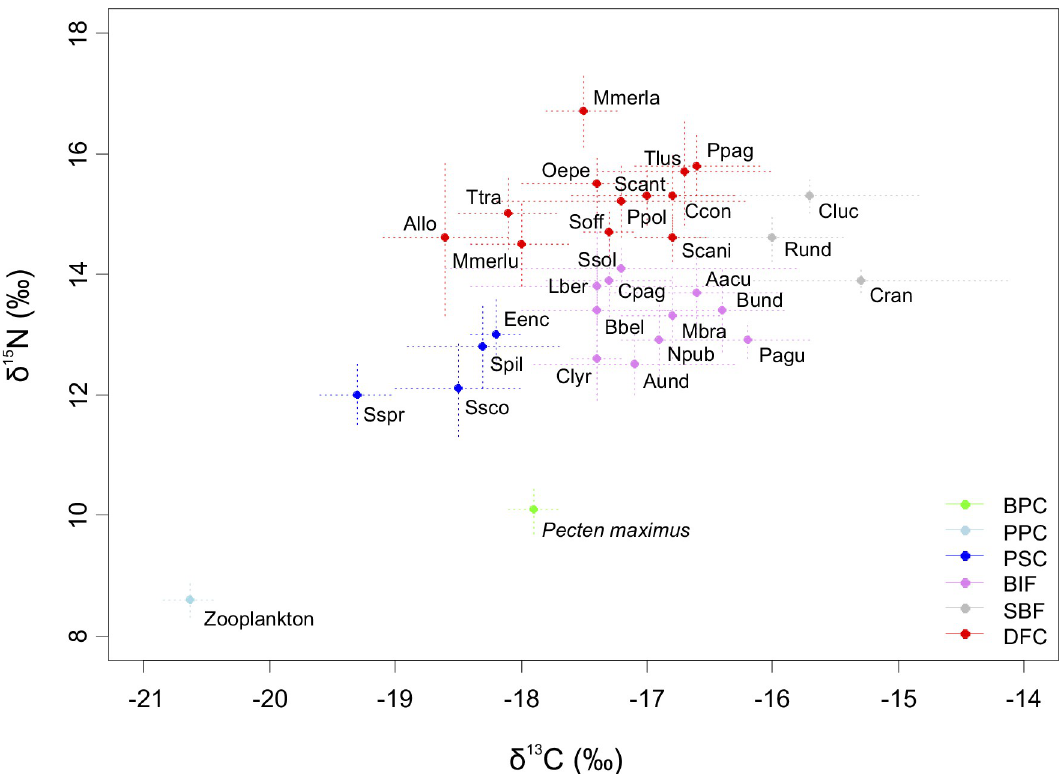
Fig 2. Stable isotope composition of the species sampled in the Bay of Bourgneuf. Data is presented as mean ± SD and species are organized in 6 different trophic groups according to hierarchical clustering. BPC = Benthic primary consumers (green). PPC = Pelagic primary consumers (light blue). PSC = Pelagic secondary consumers (blue). BIF = Benthic invertebrates and fish (black). SBF = Shrimps and benthic fish (grey). DFC = Demersal fish and cephalopods (red). Consumers’ abbreviations are provided in Table